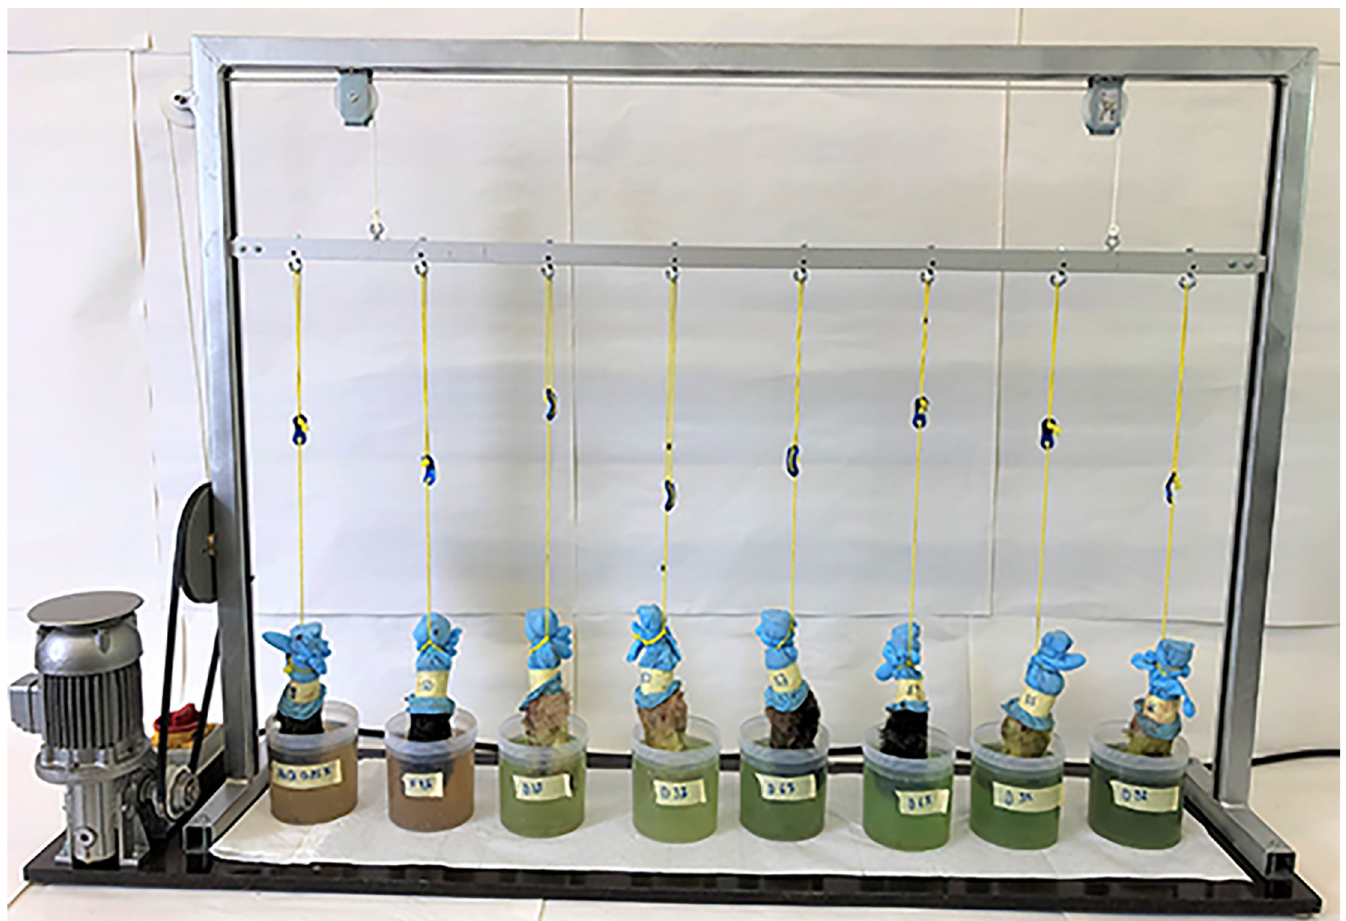
Fig 1. Foot-dipping machine. The foot-dipping machine simulates the movement of alive sheep feet in disinfectant footbath solution.